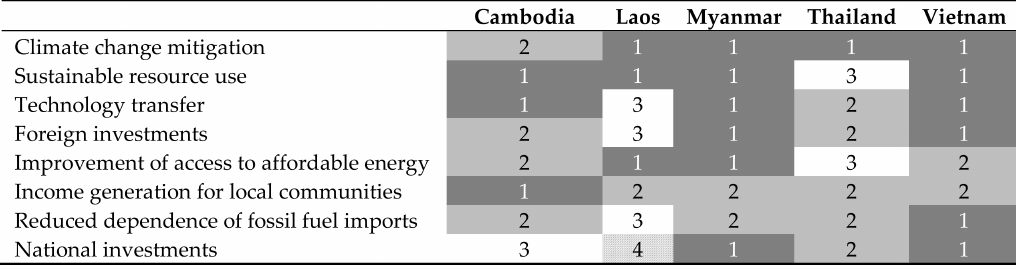
Table 4. Expected impact of the proposed network among the ACMECS countries, where 1 = very important, 2 = important, 3 = good to have, and 4 = unimportant, ranked median according to importance score from top to bottom. Background colors represent classes 1-4.